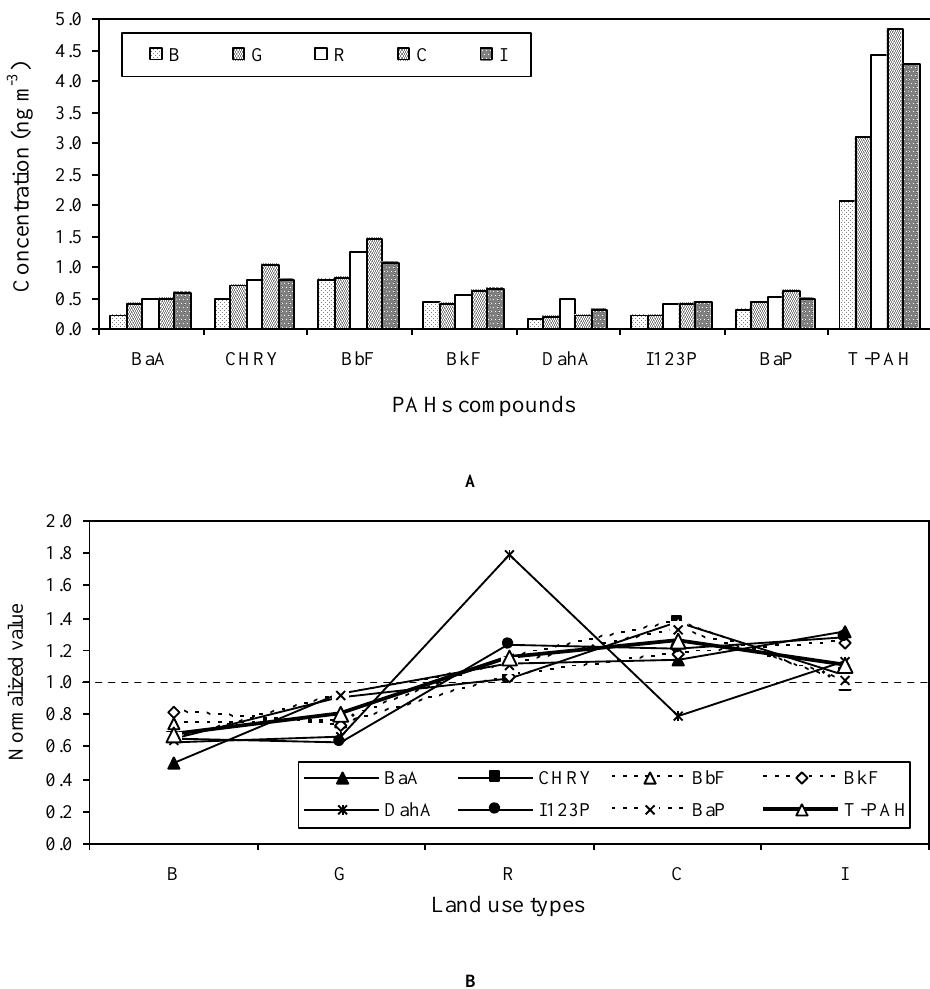
FIGURE 3. Comparison of the mean PAH concentration levels between land use types. (A) Absolute PAH concentration levels for five land use types; (B) normalization of PAH concentration